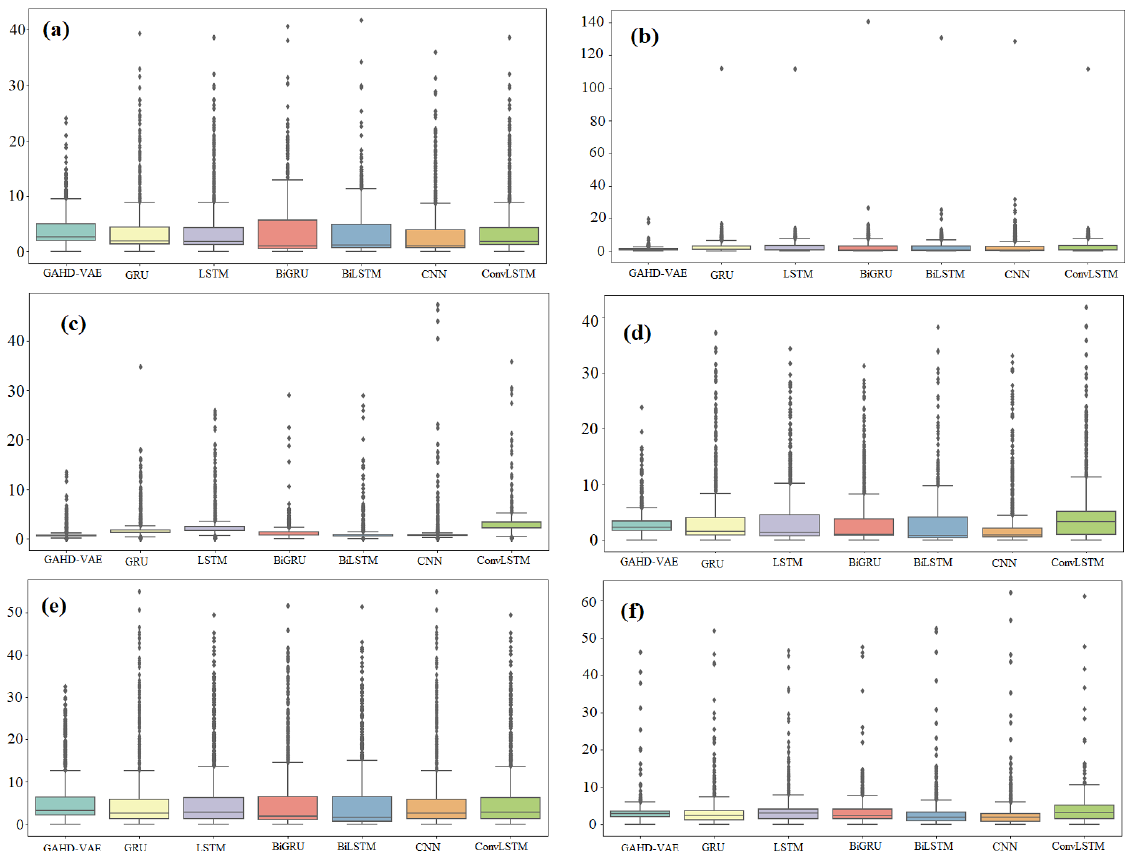
Figure 6. Boxplot of forecasting errors obtained by the seven considered methods based on the six datasets: ( a ) Data Set 1, ( b ) Data Set 2, ( c ) Data Set 3, ( d ) Data Set 4, ( e ) Data Set 5 and ( f ) Data Set